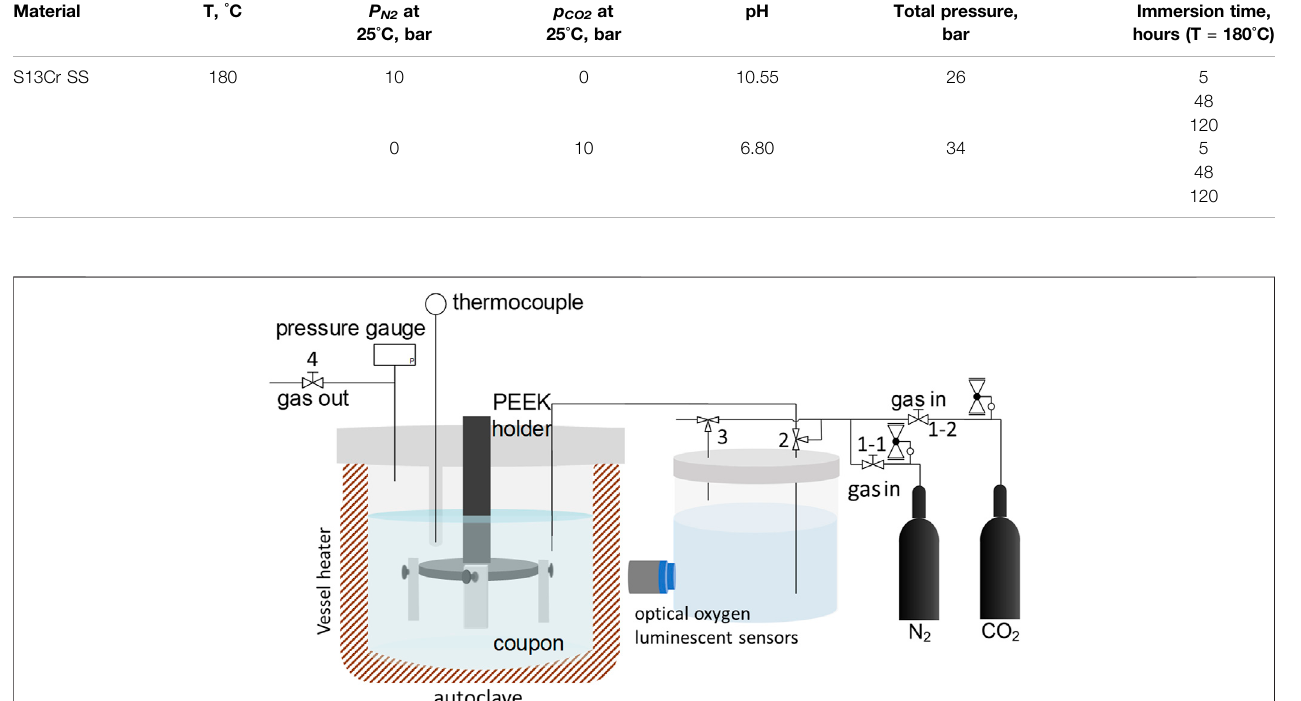
FIGURE 1 | Schematic diagram of the high-temperature and high-pressure autoclave and the location of mass loss samples.